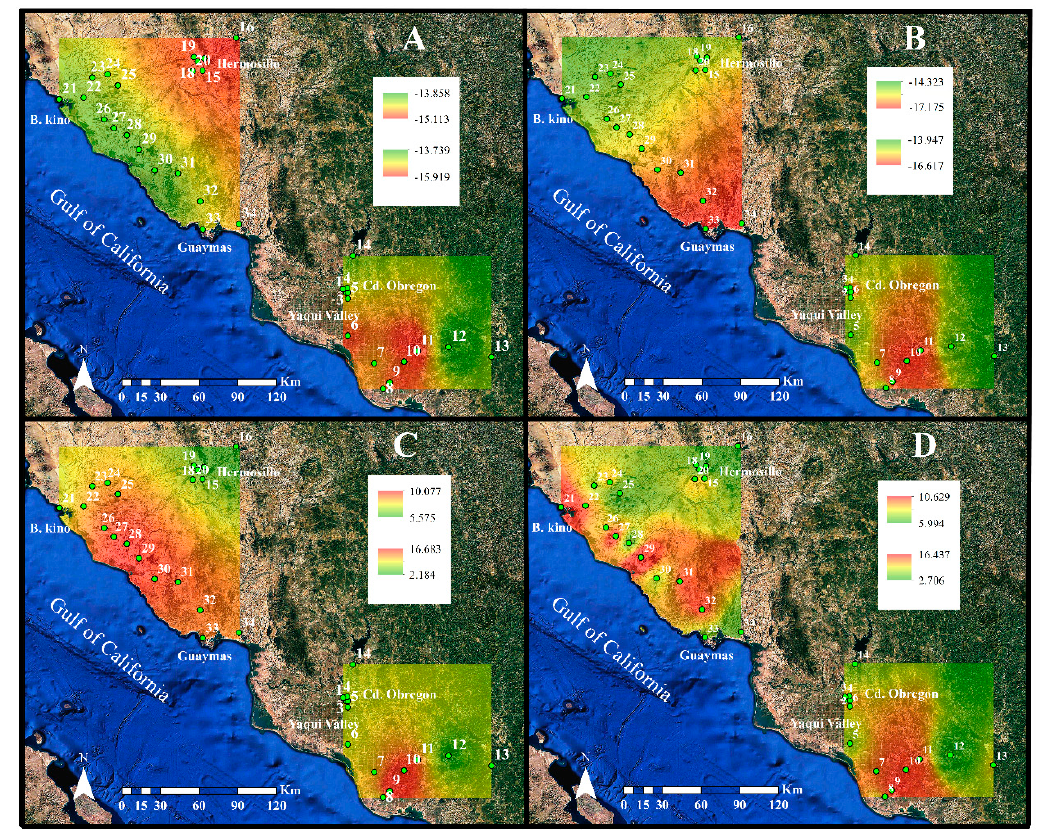
Figure 5. Spatial distribution for buffelgrass isotopic composition in Sonora, Mexico. Carbon isotopic composition ( δ 13 C, ‰ ) for ( A ) leaves and ( B ) seeds and nitrogen isotopic composition ( δ 15 N, ‰ ) for ( C ) leaves and ( D ) seeds. Image data: Google Earth; date: 20 April